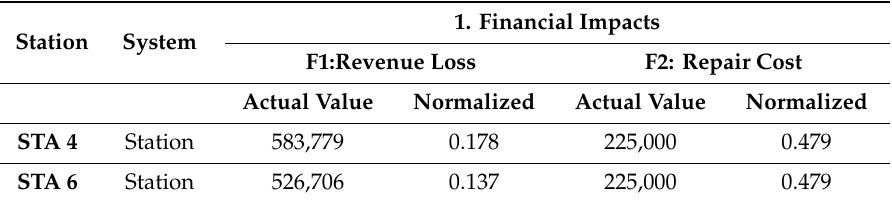
Table 5. Financial Impacts Scores.